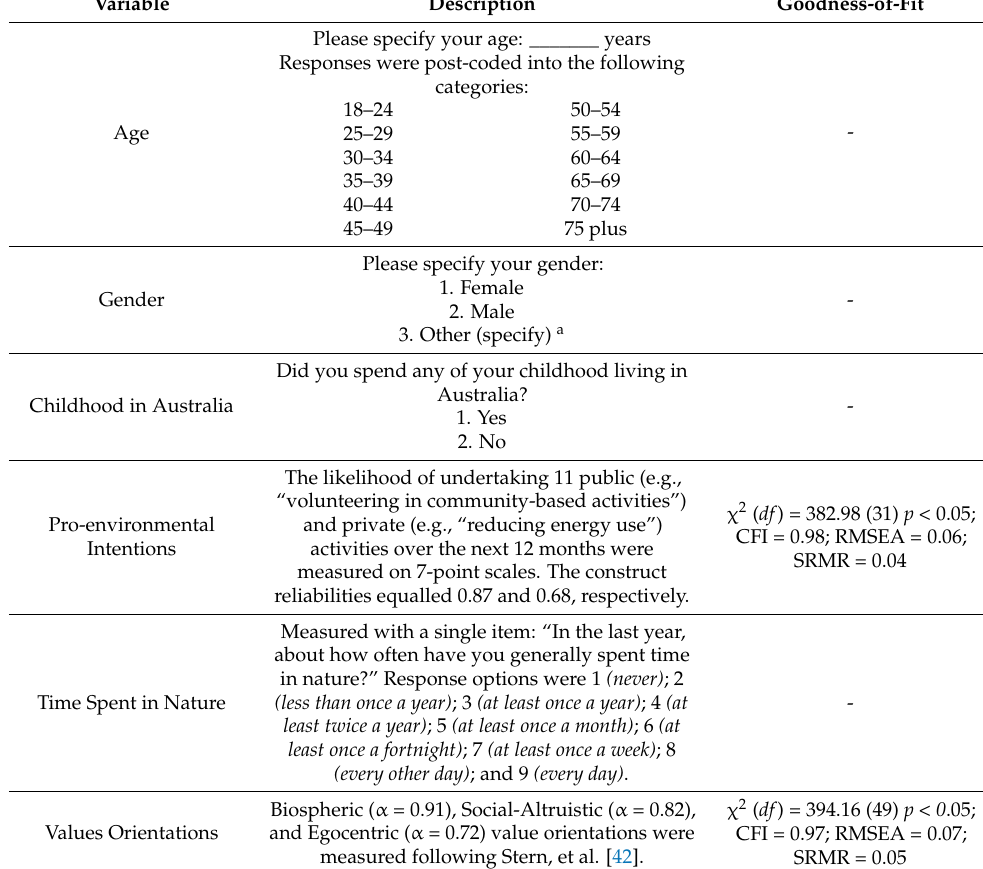
Table 4. Variable description and